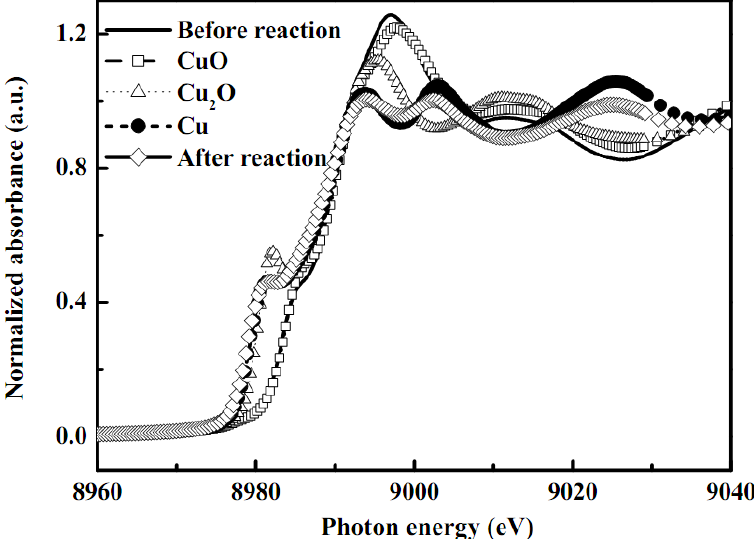
Figure 7. XANES spectra of copper standards and copper species in the as-synthesized CuO/ZnO-Al O catalyst washcoat with ZrO 2 3 methanol in a microreactor.